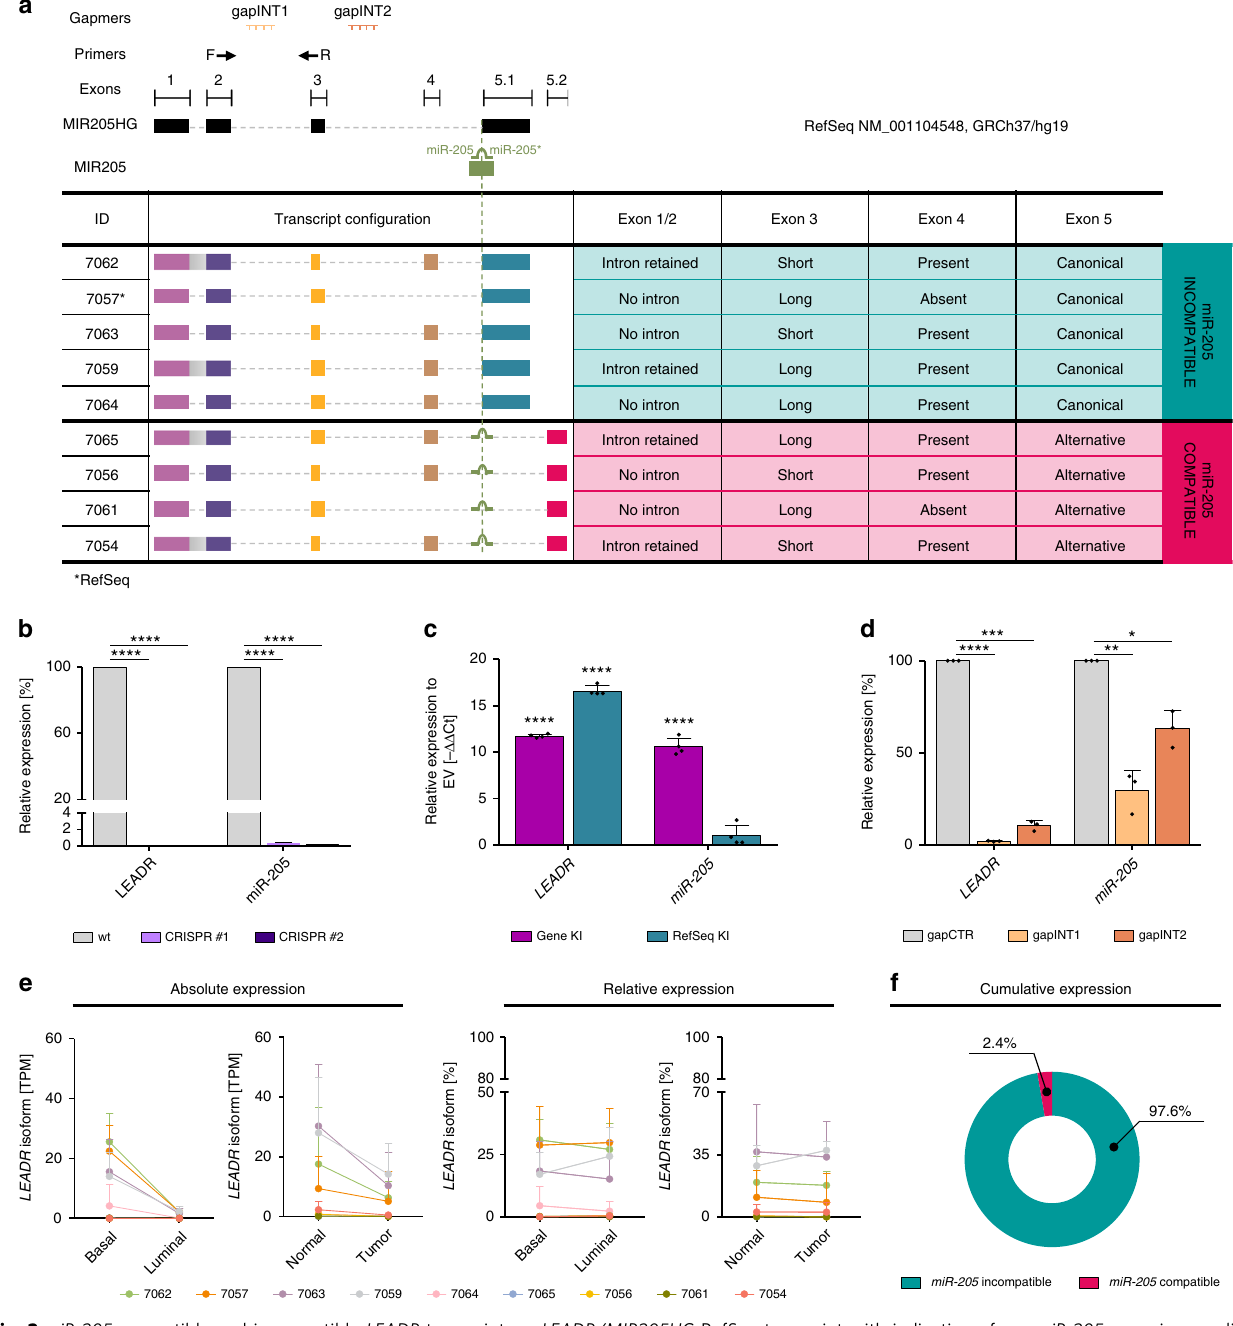
Fig. 2 miR-205 compatible and incompatible LEADR transcripts. a LEADR/MIR205HG RefSeq transcript with indication of pre- miR-205 spanning a splice junction, position of primers (Forward, F, and Reverse, R) generally used for LEADR qRT-PCR and target sequences of gapINT1 and gapINT2 in the introns of LEADR/MIR205HG primary transcript ( top ). Table reporting bona fi de LEADR/MIR205HG alternative transcripts, ranked for expression in prostate basal cells, with indication of exon composition and compatibility with miR-205 biogenesis ( bottom ). b qRT-PCR showing LEADR and miR-205 expression in two independent RWPE-1 cell clones genomically edited for LEADR gene using CRISPR/Cas9, as compared to wild-type cells. Mean + s.d. ( n = 3 qRT-PCR measurements for each clone) plotted. gRNAs used for editing and genotyping of bulk population and single-cell clones are reported in Supplementary Fig. 3d. c qRT-PCR showing LEADR and miR-205 expression in DU145 cells knocked-in for either the whole LEADR genomic sequence (referred to as “ gene ” ) or the RefSeq transcript, as compared to empty vector (EV). Mean + s.d. ( n = 4) plotted. d qRT-PCR showing repression of both LEADR and miR-205 in RWPE-1 cells at day 3 after transfection with two different intronic gapmer oligonucleotides. Mean + s.d. ( n = 3) plotted. e Absolute ( left ) and relative ( right ) expression of LEADR transcript isoforms as from RNA-Seq data of basal vs. luminal cells (GSE67070) or of normal vs. tumor tissues (GSE22260). Relative expression calculated as percentage of each isoform respect to the total isoforms. f Average cumulative fraction of miR-205 incompatible and compatible LEADR transcripts in prostate cells. ∗ p < 0.05; ∗∗ p < 0.01; ∗∗∗ p < 0.001; ∗∗∗∗ p < 0.0001 (Student ’ s t test). Source data are provided as a Source Data fi le, together with n of all